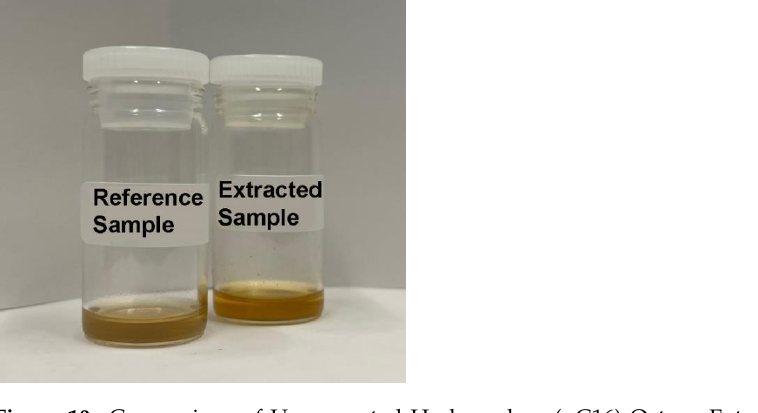
Figure 10. Comparison of Unconverted Hydrocarbon (>C16) Octane Extract from the CFC and a Reference Sample prepared with One Drop ( ≈ 0.05 mL) of VGO in N-Octane.